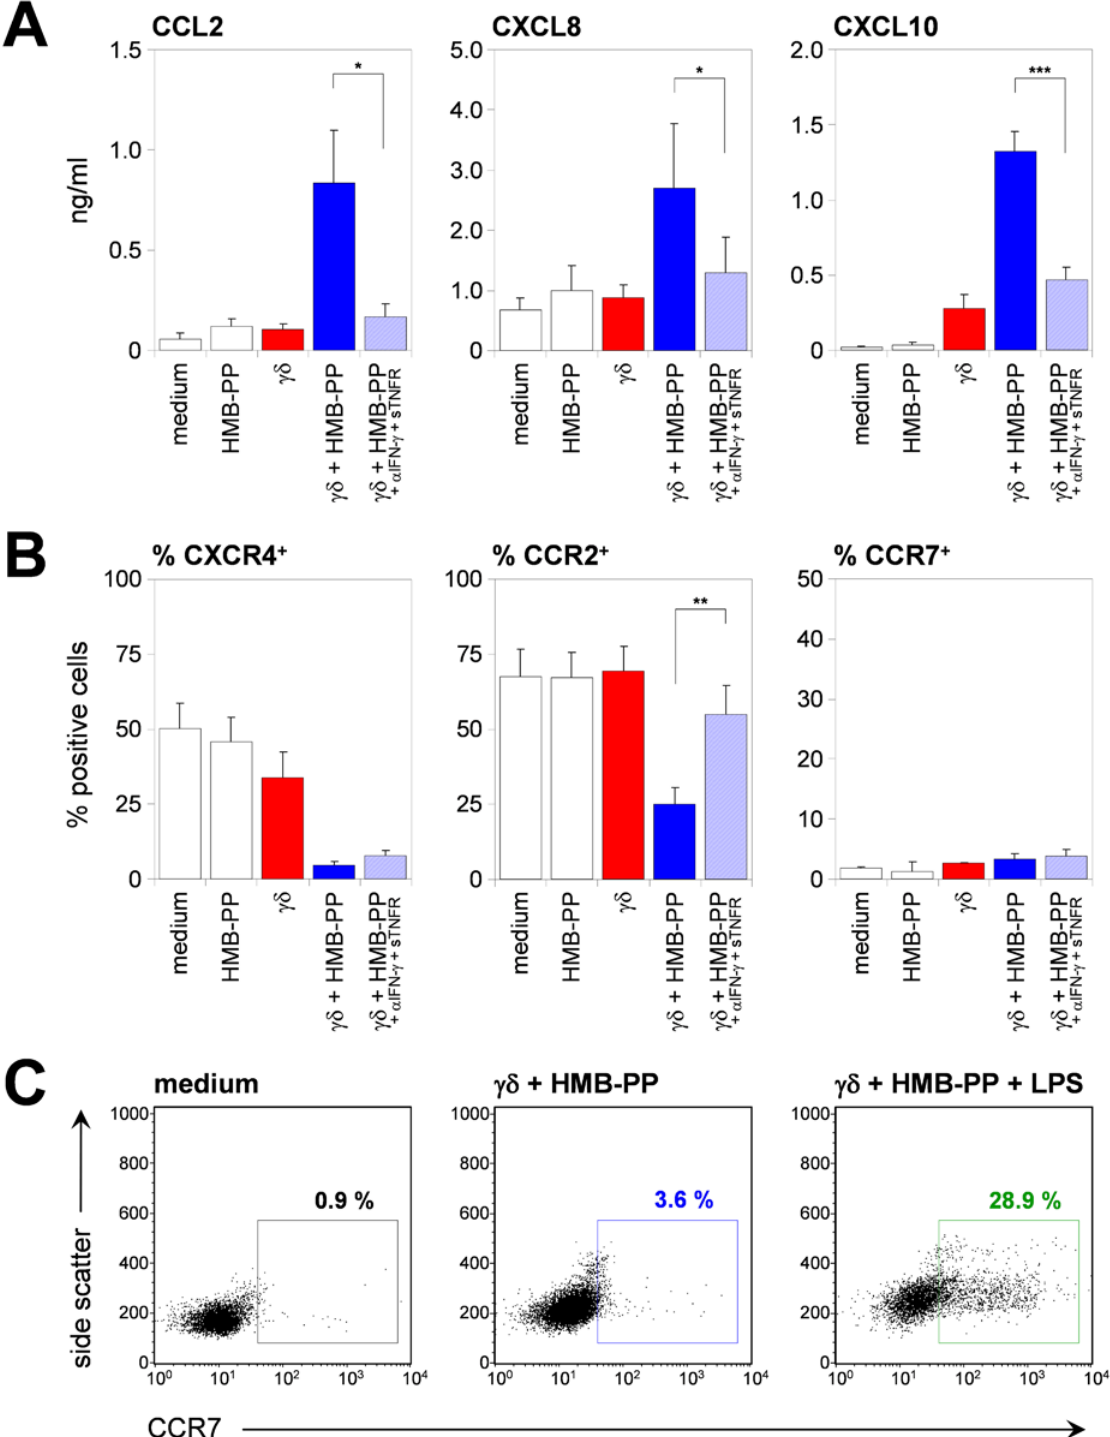
Figure 6. V c 9/V d 2 T cell-activated monocytes possess altered migratory properties. ( A ) Mean protein levels (pg/ml) 6 SEM of secreted CCL2, CXCL8, and CXCL10, and ( B ) mean percentages 6 SEM of CXCR4 + , CCR2 + , and CCR5 + monocytes after 18 hours of culture under the conditions indicated ( n =3–8). ( C ) Side scatter and CCR7 fluorescence for monocytes after 18 hours of culture in medium, or with cd T cells + HMB-PP in the absence or presence of LPS; representative of two independently assessed donors.